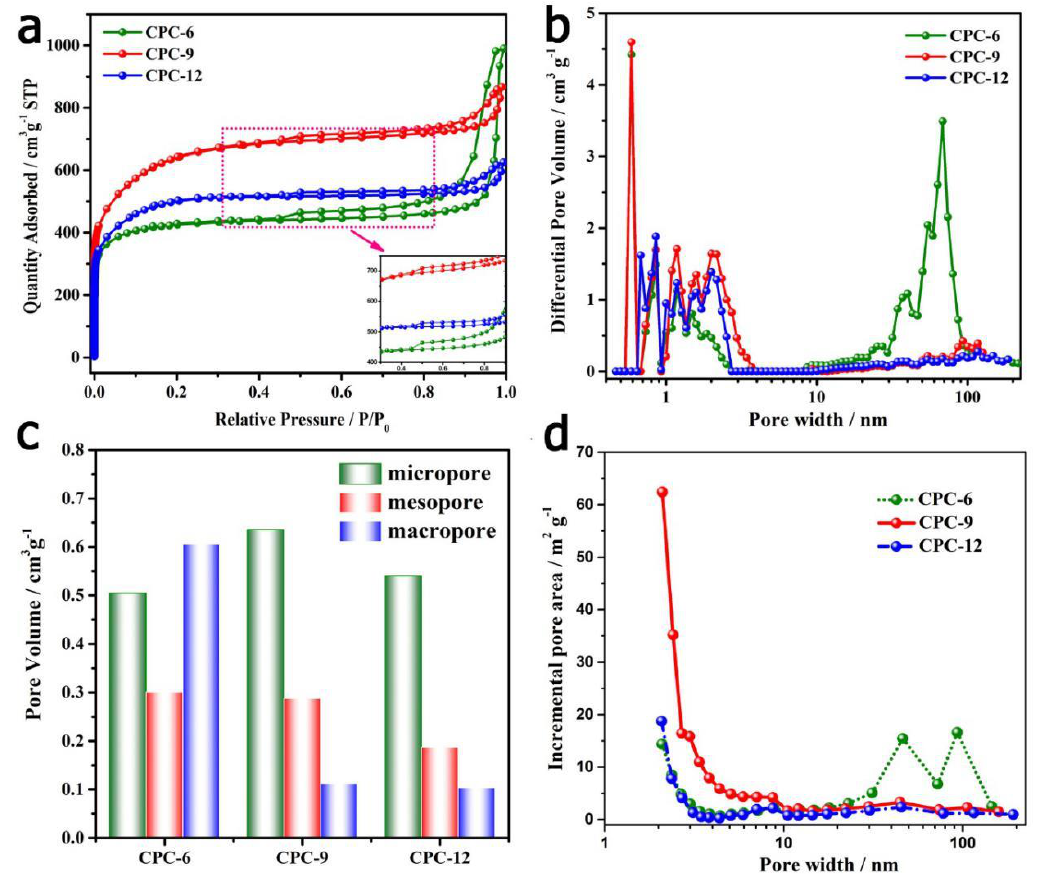
Figure 2. ( a ) nitrogen adsorption / desorption isotherms of the samples; ( b ) pore size distribution for N 2 (calculated by using the DFT model); ( c ) pore volume for N 2 (calculated by using the DFT model); ( d ) incremental pore area distribution (calculated by using BJH model).